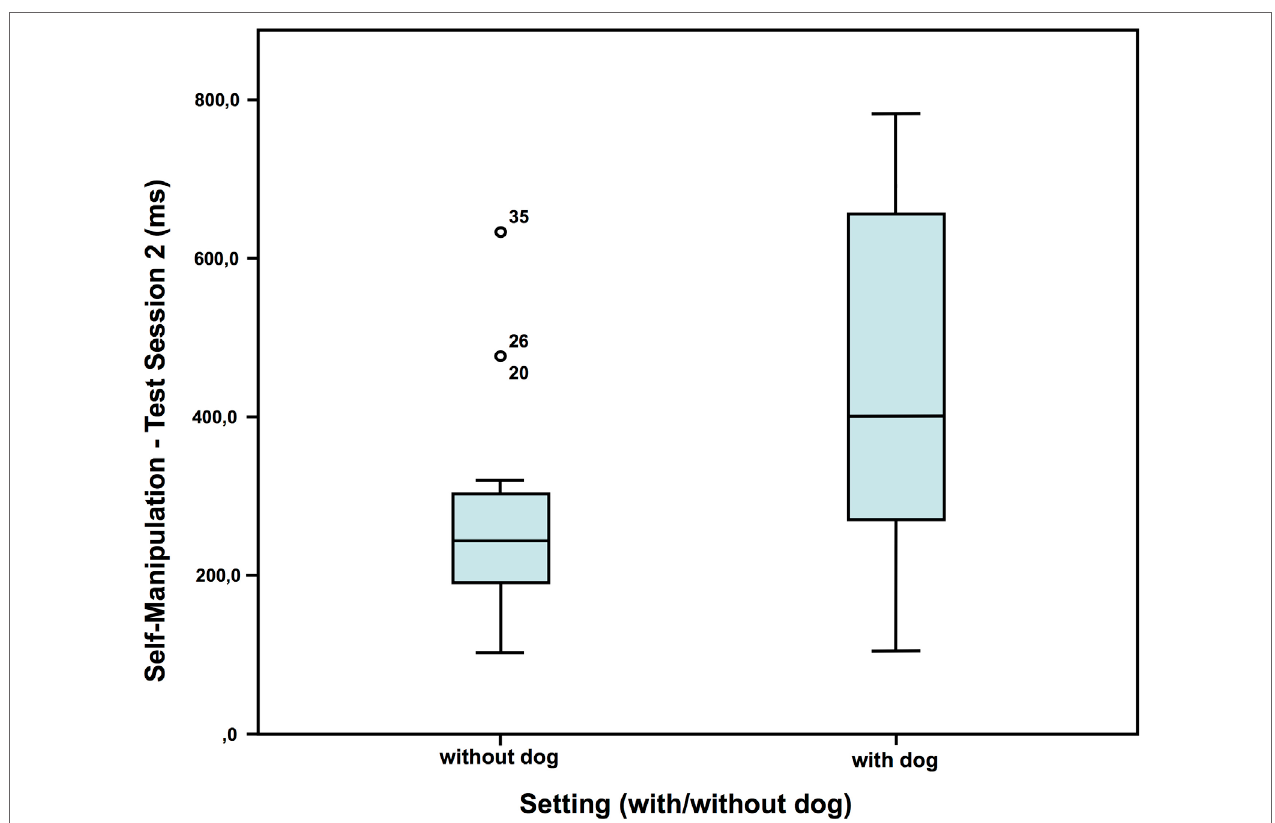
FigUre 4 | Duration of self-manipulation in test session 2—comparison of the two settings